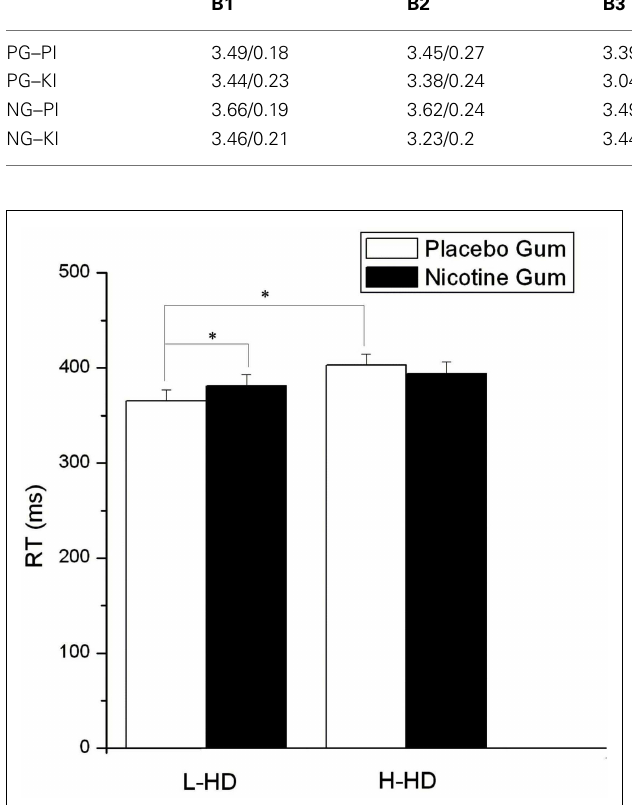
FIGURE 7 | Effects of placebo and nicotine gum (collapsed across placebo and ketamine infusions and the three time blocks) on mean ( ± SE) reaction time (RT) in L-HD and H-HD groups (* p < 0.05).